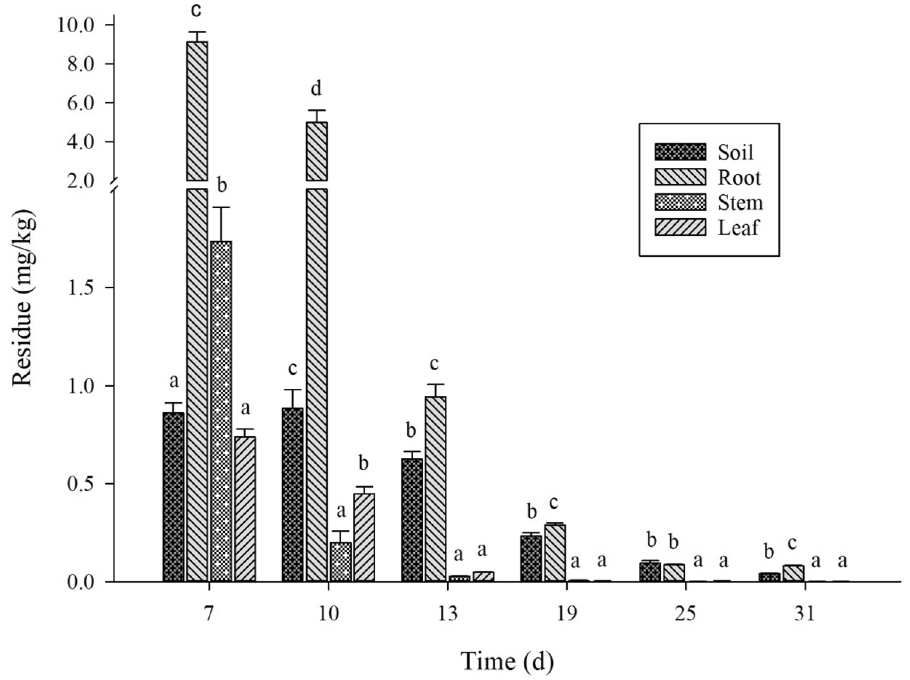
Figure 5. The degradation dynamics of spinetoram in different parts of the flowering cabbage. The Y-axis represents the spinetoram residual amount and the X-axis represents the number of days post-treatment. Alphabets (a–d) indicate the statistical significance at P ≤